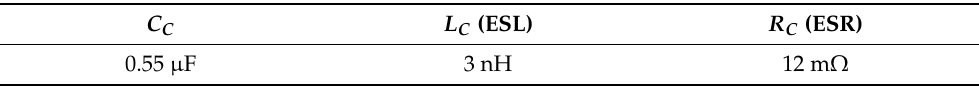
Figure 19. Equivalent circuit model of the mounted capacitors. The parameter values are shown in Table 4. Table 4. Parameters of the capacitor model depicted in Figure 19 obtained from the datasheet [18].